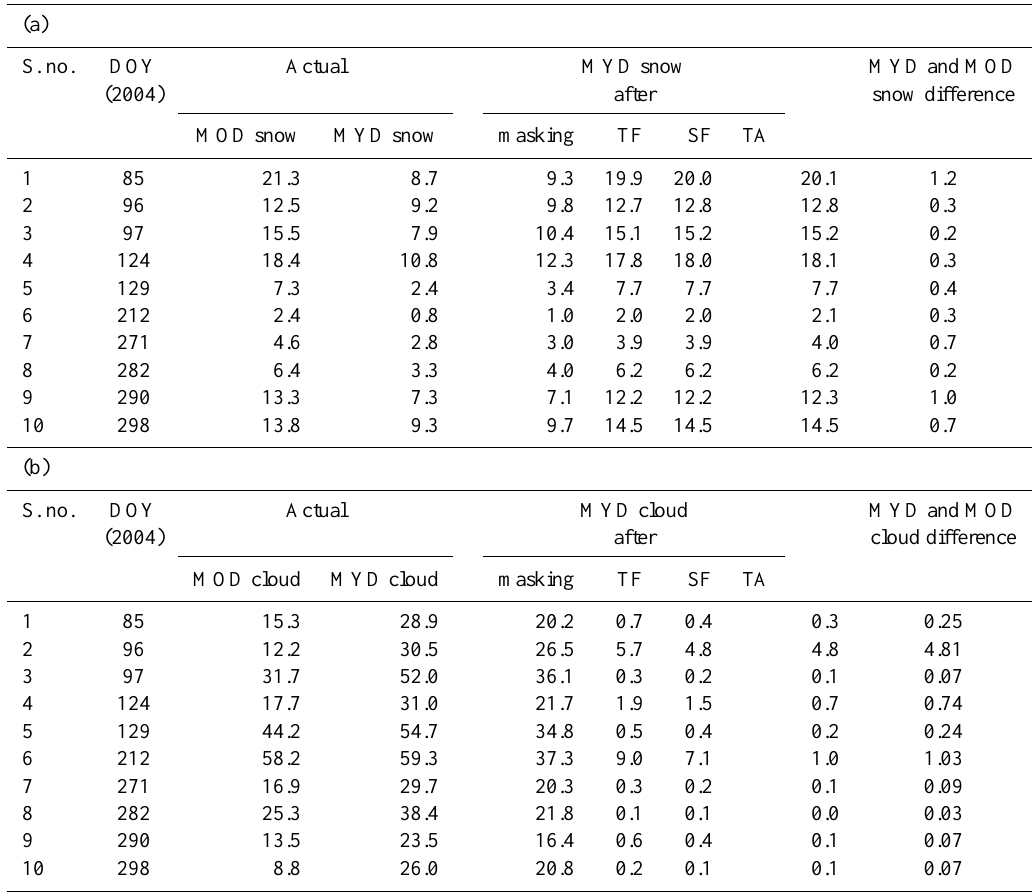
Table 5. (a) Relative validation: snow cover estimates (%) for AOI, actual and after applying each cloud removal step for the selected dates within the validation period of the year 2004. Note: MAD is 0.54. (b) Same as (a) , but for the cloud cover estimates.